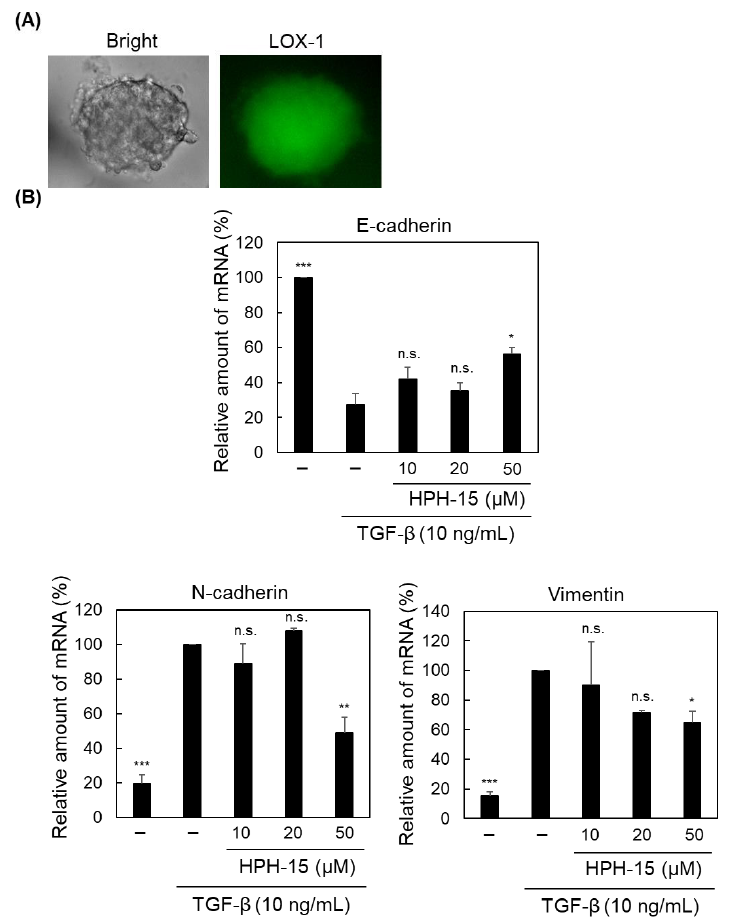
Figure 3. Anti-EMT activity of HPH-15 in 3D-cultured cells. ( A ) Morphology and hypoxic status of a spheroid containing A549 cells. A549 cells were cultured in a non-adhesive plate for 2 d to prepare spheroids, and their morphology was observed using a microscope (left). After incubating the sphe- roid for 16 h with the hypoxia probe LOX-1, fluorescence microscopy was performed (right). ( B ) mRNA levels of E-cadherin, N-cadherin, and Vimentin in a TGF- β -stimulated A549 spheroid ( A ) treated with HPH-15. After incubating the spheroid for 1 d in the presence of various amounts of HPH-15 and TGF- β (10 ng/mL), RNA was extracted from the spheroid, and RT -PCR was performed. Relative values are shown. * p < 0.05, ** p < 0.01, *** p < 0.001; n.s. — not significant compared with samples treated with TGF- β and without HPH-15.